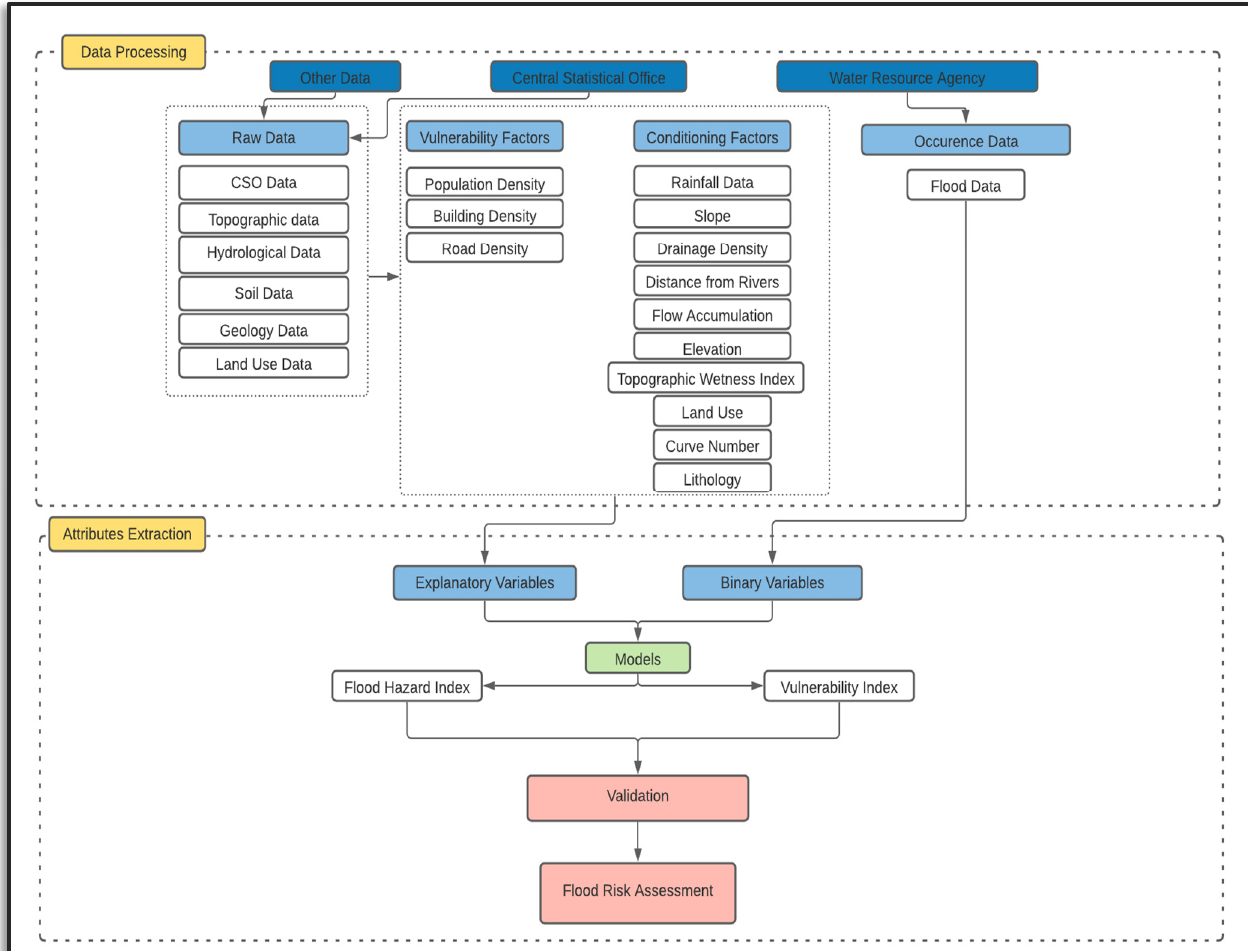
Figure 3. Conceptual framework for Trinidad Risk Assessment.